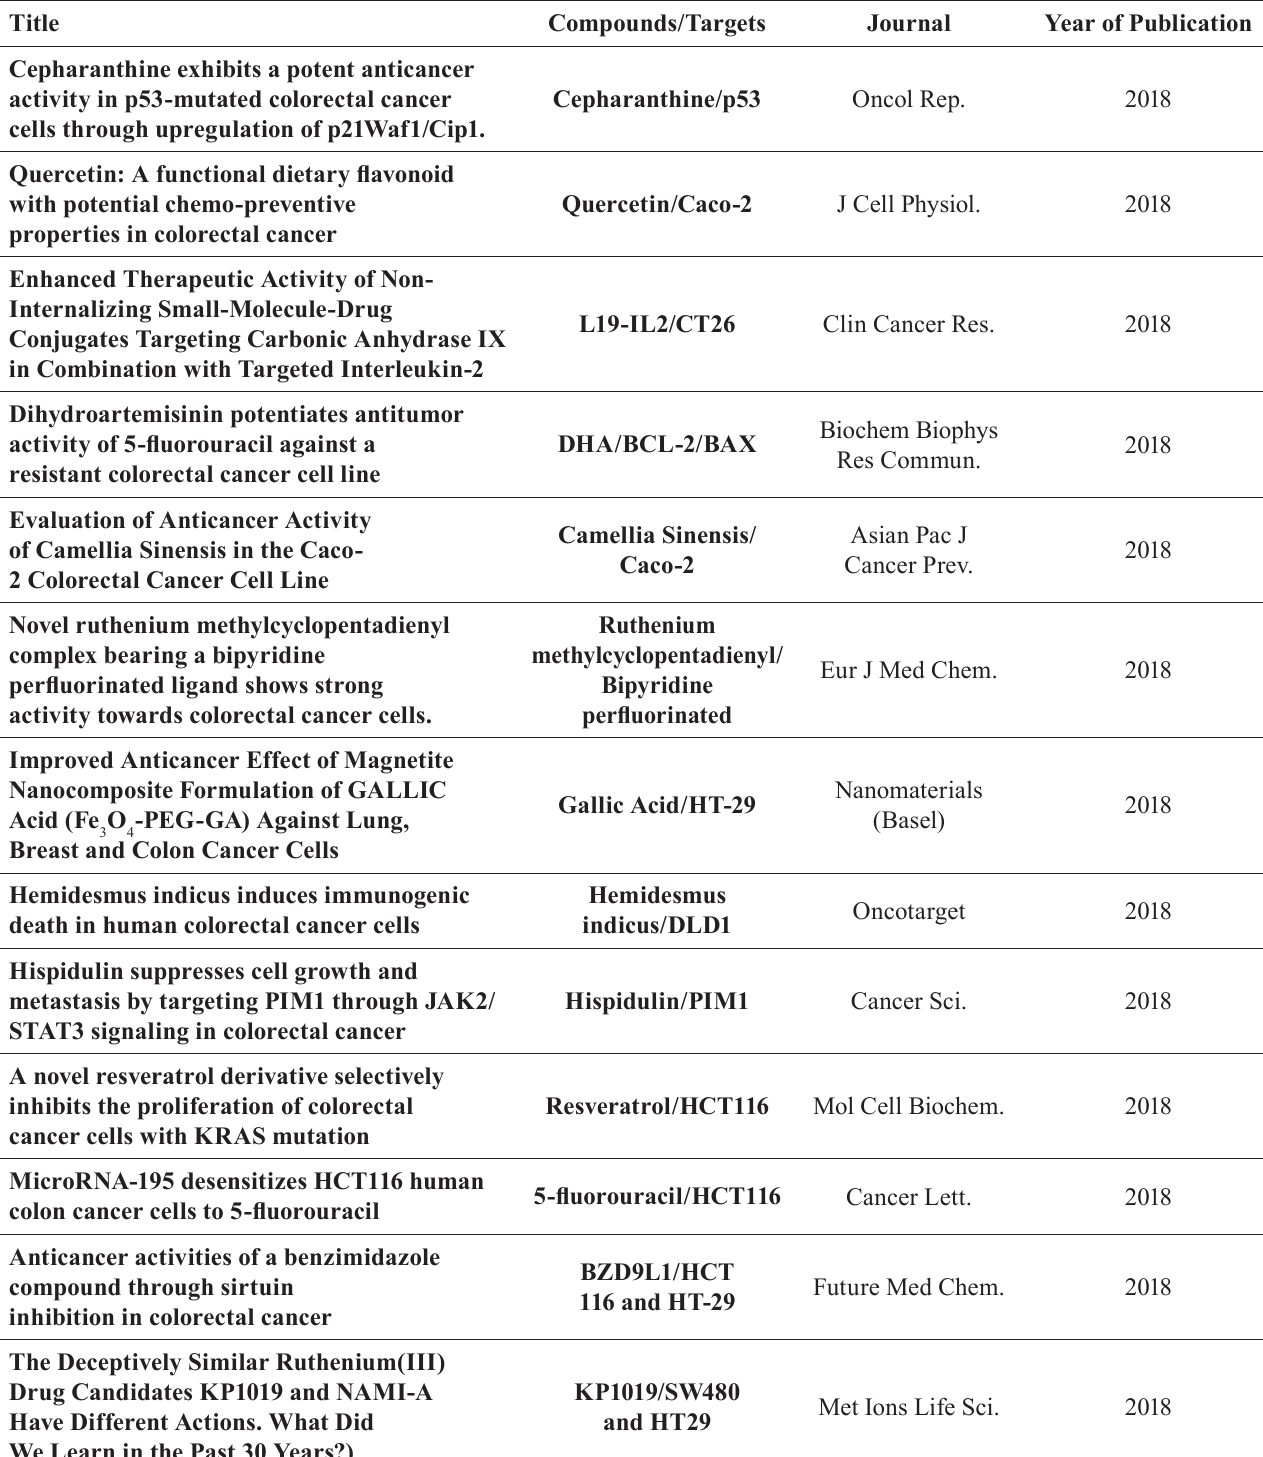
TABLE II – Potential CRC-related drugs identified in PubMed articles, followed by related tumor targets and their